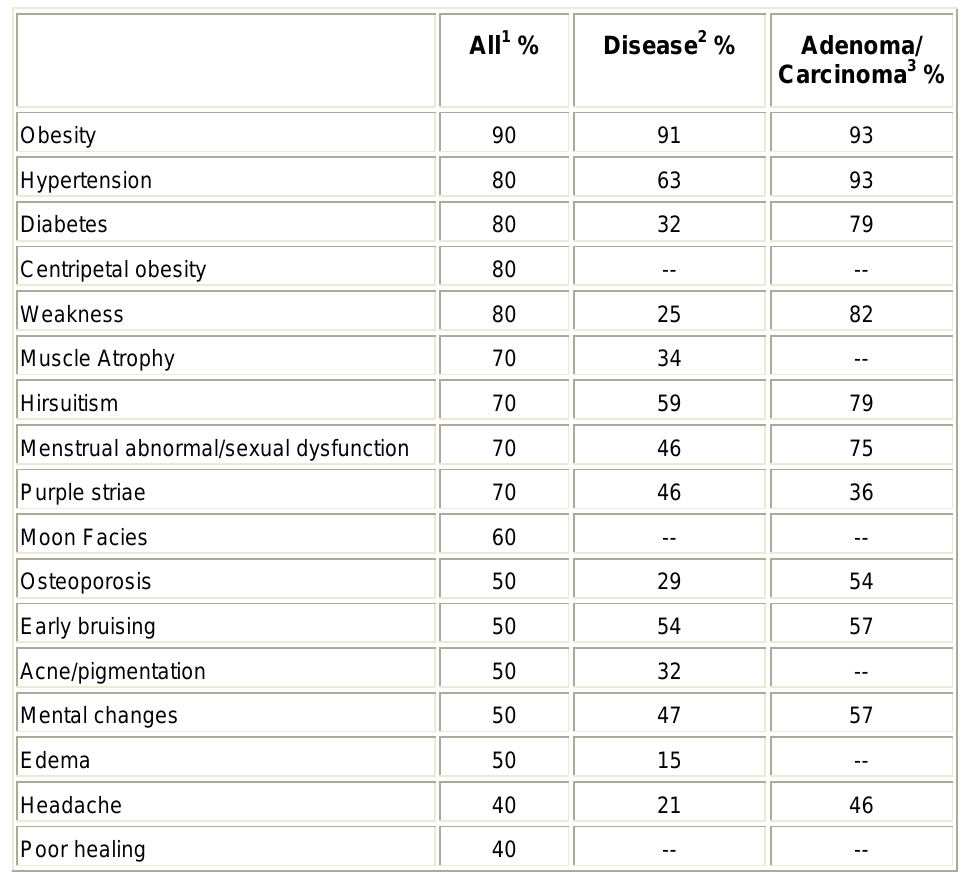
Clinical Manifestations of Cushing's Syndrome All 1